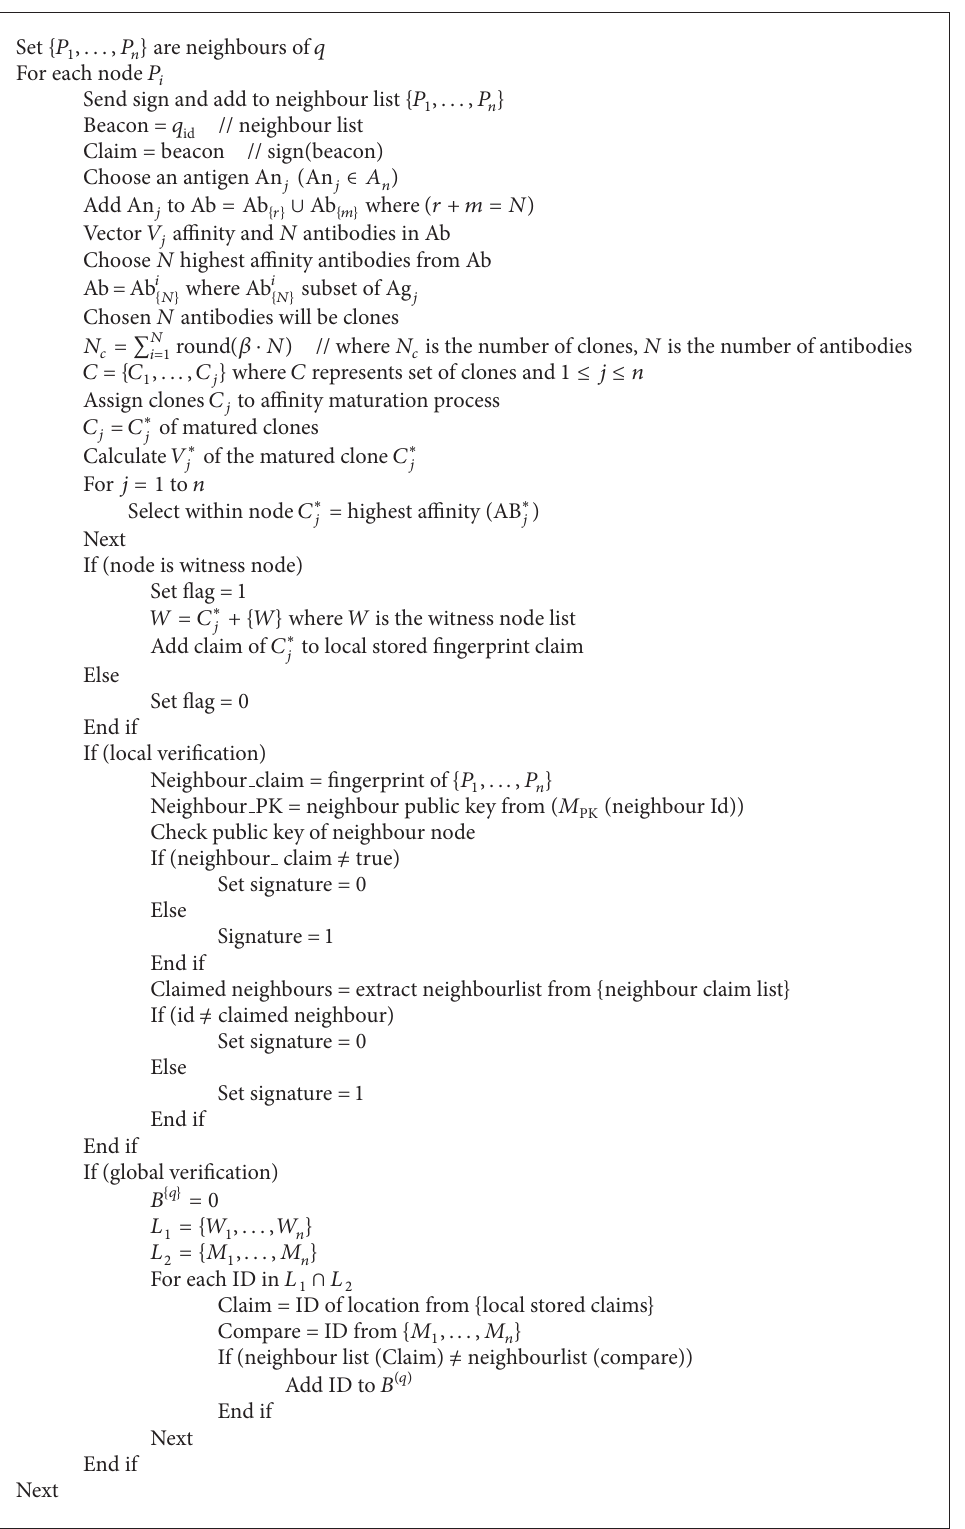
Algorithm 4: Proposed enhanced Single Hop Detection using Clonal Selection Algorithm